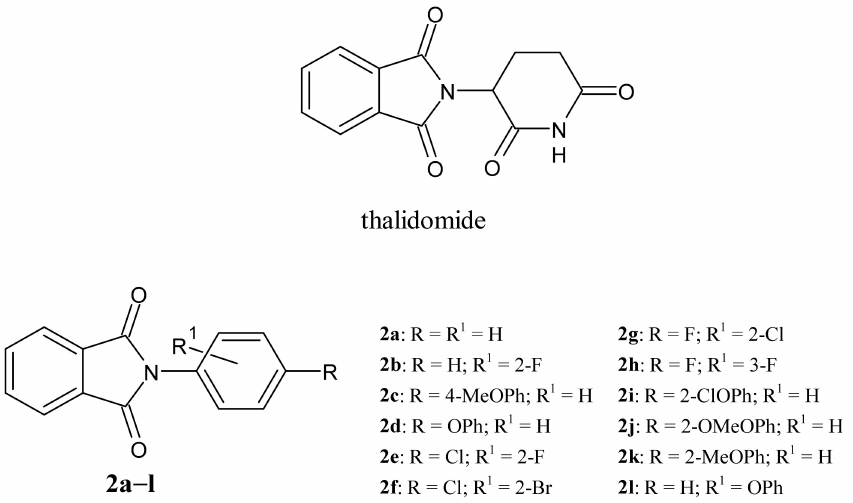
Figure 1. Structure of thalidomide and correlated compounds ( 2a – l